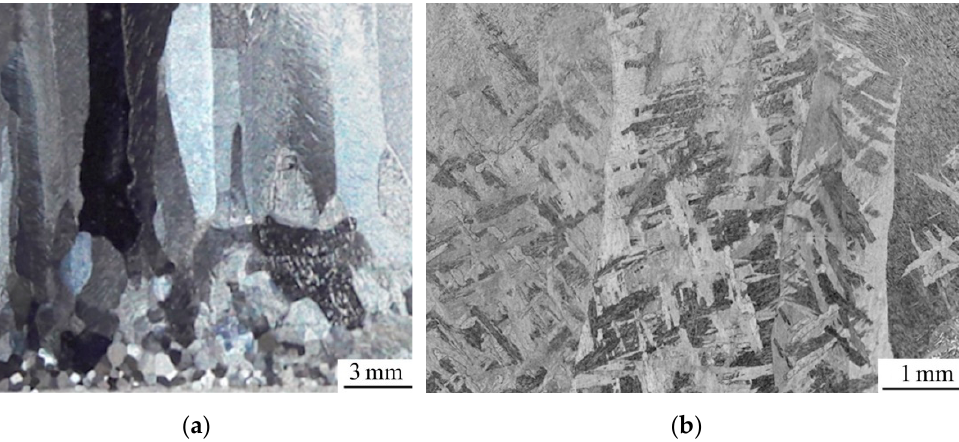
Figure 2. Optical micrographs of the grain structure ( a ) and microstructure ( b ) of the EBAM Ti-6Al-4V samples produced without substrate cooling. The microstructures were obtained from the longitudinal direction (parallel to the build direction) in the lower ( a ) and central ( b ) parts of the rectangular Ti-6Al-4V bar.